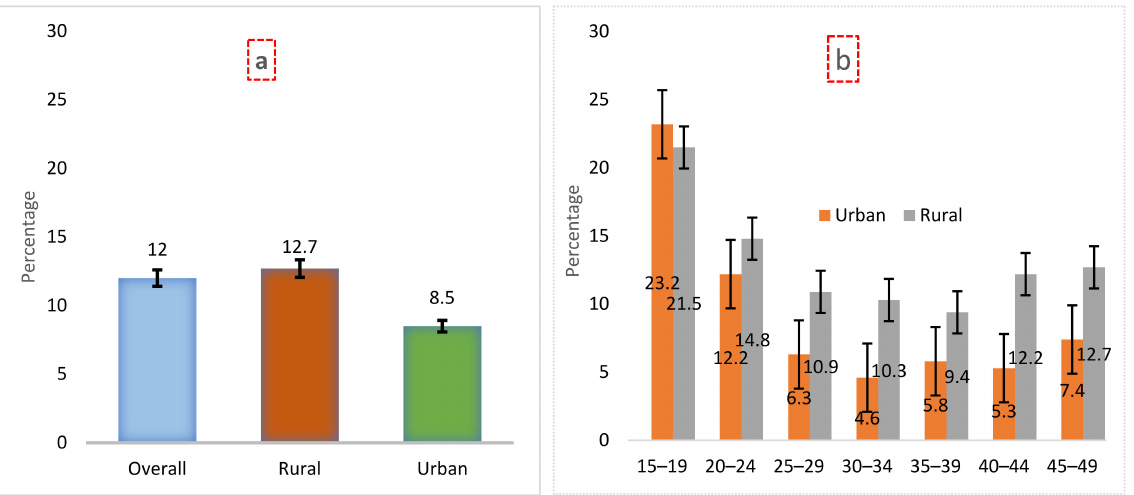
Figure 2. ( a ) Overall and residence-specific prevalence of undernutrition among women of reproduc-